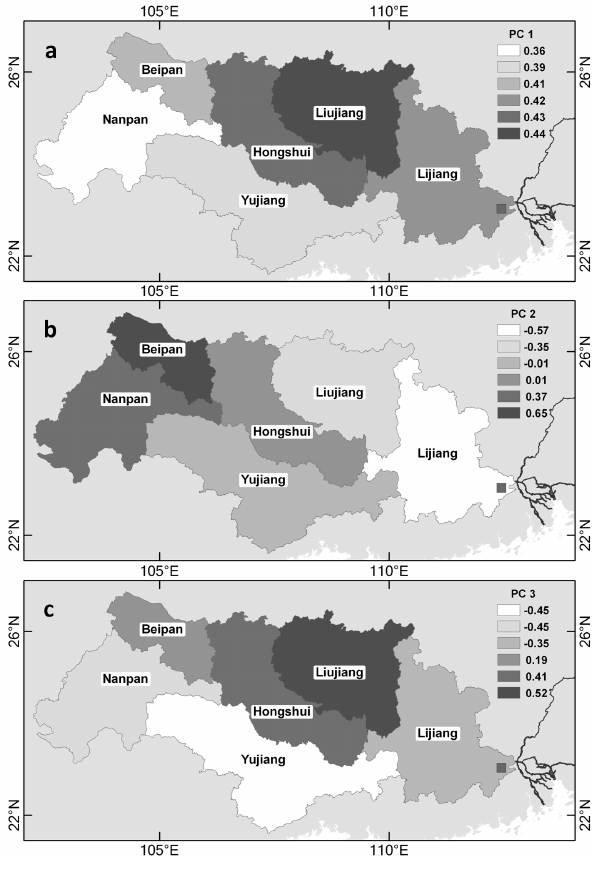
Fig. 8. Loading pattern of PC-1 (a) , PC-2 (b) , and PC-3 (c) in the six sub-basins of the Xijiang River basin.